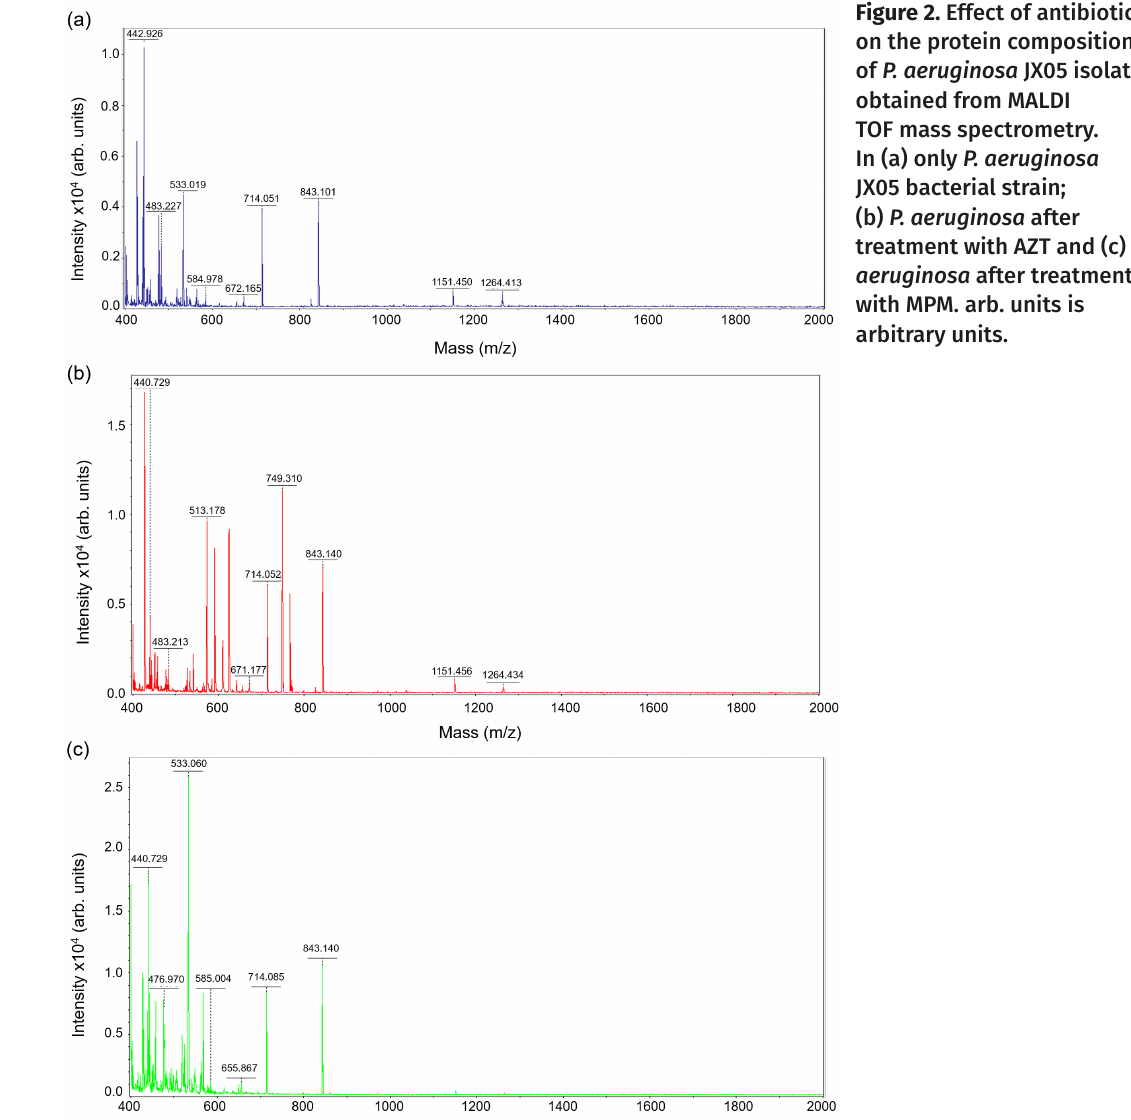
Figure 2. Effect of antibiotics on the protein composition of P. aeruginosa JX05 isolate obtained from MALDI TOF mass spectrometry. In (a) only P. aeruginosa JX05 bacterial strain; (b) P. aeruginosa after treatment with AZT and (c) P. aeruginosa after treatment with MPM. arb. units is arbitrary